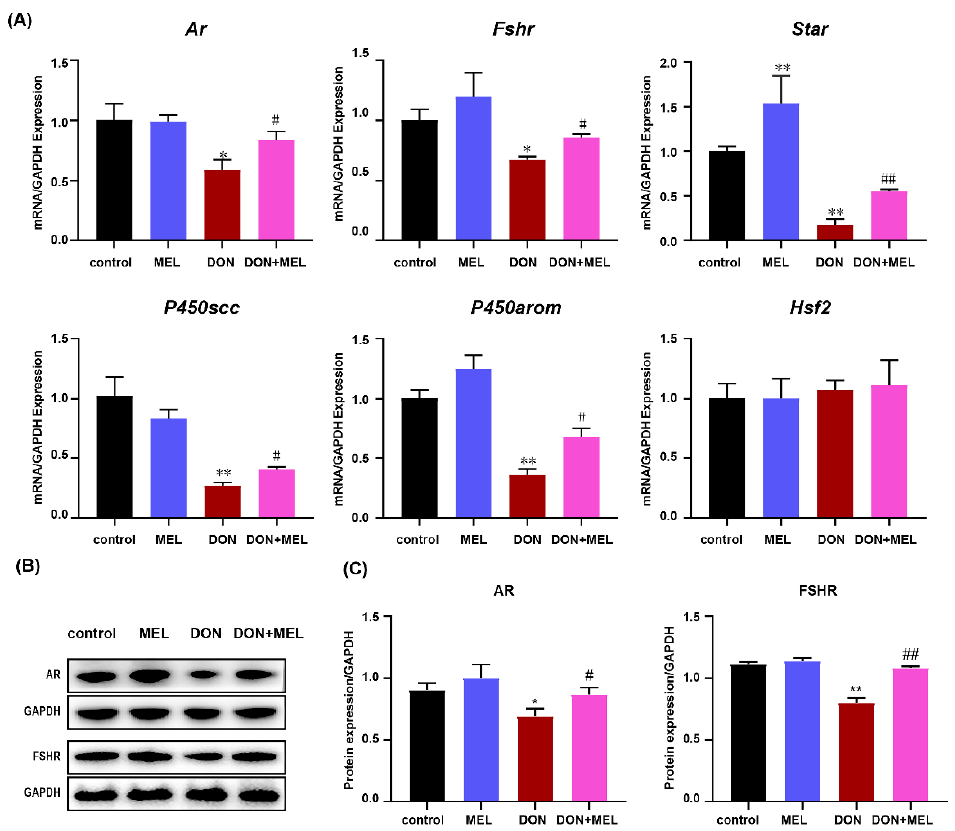
Figure 5. Effect of melatonin on DON-induced expression of reproductive hormone-related genes in mouse ovary GCs, measured by qRT-PCR and western blotting. Ovarian GCs were stimulated with DON, melatonin (MEL), and DON+MEL for 24 h. ( A ) The relative expression levels of Ar , Fshr , Star , P450scc , P450arom , and Hsf2 were calculated by dividing their values by the Gapdh mRNA expression level. All data are expressed as the means ± SEM. (( B ) and ( C )) The protein levels of AR (1:1000 dilution) and FSHR (1:1000 dilution) in murine ovary GCs, assessed using western blot. GAPDH (1:5000 dilution) as the control. The results from each group are shown as the mean ± SD, n = 3. * p < 0.05 and ** p < 0.05 compared with the control and MEL groups; # p < 0.05 and ## p < 0.05 compared with the DON group. MEL: melatonin.